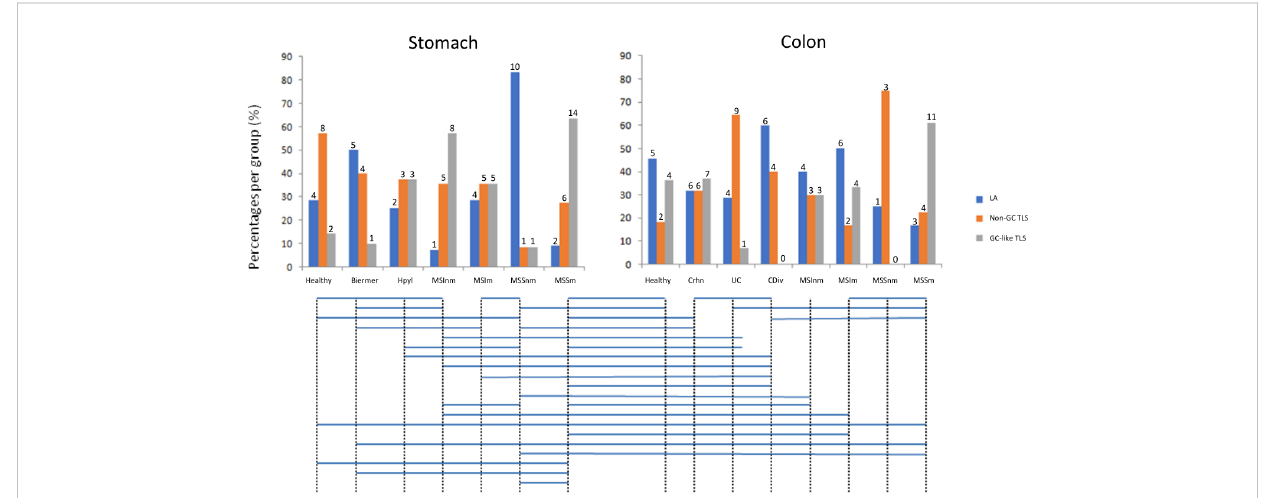
FIGURE 4 Distributions of the three stages of TLS across the different sample groups. Groups with signi fi cantly different distributions (p<0.05) are joined by horizontal bars under the histograms. The quantitative numbers of TLS are represented above each bar. LA: lymphoid aggregates; Non-GC TLS: non-germinal center TLS; GC-like TLS: germinal center-like TLS; groups A to E2 correspond to gastric samples: A: no gastric disease, B: Biermer ’ s autoimmune gastritis, C: Helicobacter pylori-related gastritis, D1: microsatellite instable gastric cancers without nodal metastasis, D2: microsatellite instable gastric cancers with nodal metastasis, E1: microsatellite stable gastric cancers without nodal metastasis, E2 microsatellite stable gastric cancers with nodal metastasis; groups 1 to 6B correspond to colonic samples: 1: Peyer ’ s patches, 2: Crohn ’ s disease, 3: ulcerative colitis, 4: chronic diverticulitis, 5A: microsatellite instable colonic cancers without nodal metastasis, 5B: microsatellite instable colonic cancers with nodal metastasis, 6A: microsatellite stable colonic cancers without nodal metastasis, 6B: microsatellite stable colonic cancers with nodal